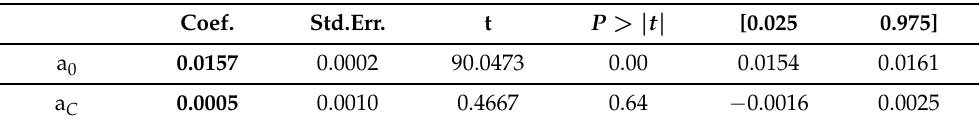
Table 5. Estimation of absorption parameters depending on CO 2 temperature proxy with measured data from 1950 to 2000.